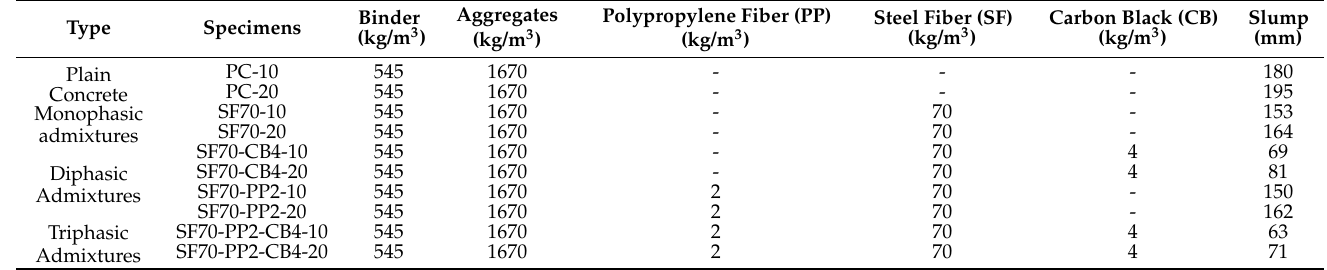
Table 2. Mix proportions of concrete with conductive and nonconductive